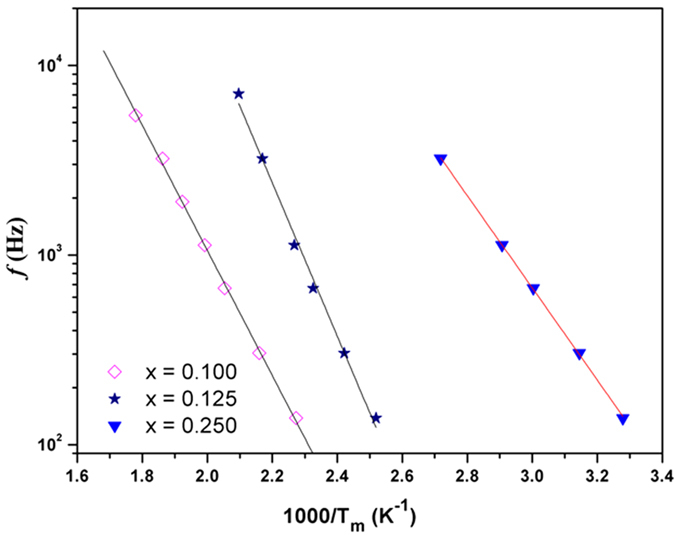
Variation of peak maxima of relaxation peak (Tm) with frequency for biphasic compositions in SrTi1−2xFexTaxO3 compositions (x = 0.10, 0.125, and 0.25).Solid lines are fit to the Arrhenius relation.